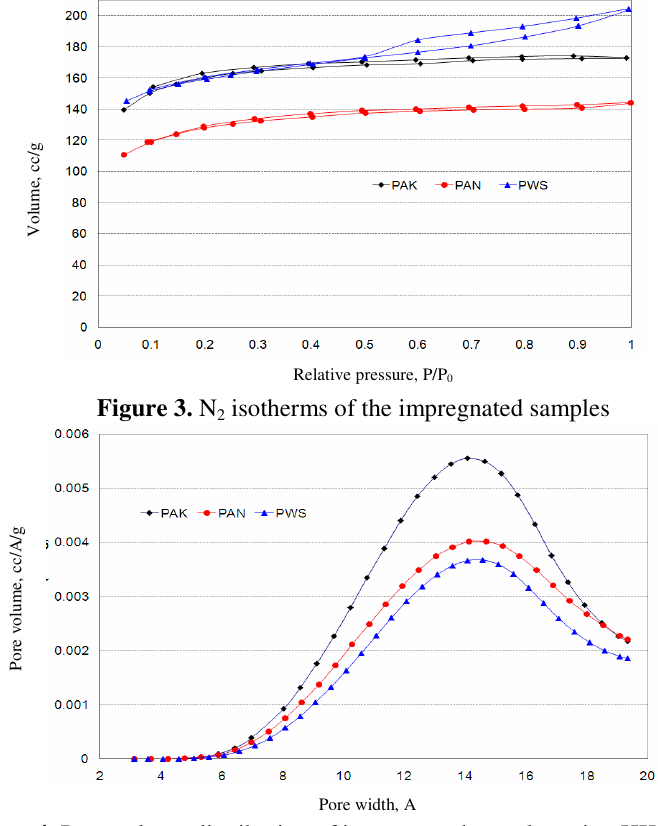
Figure 4. Pore volume distribution of impregnated samples using HK